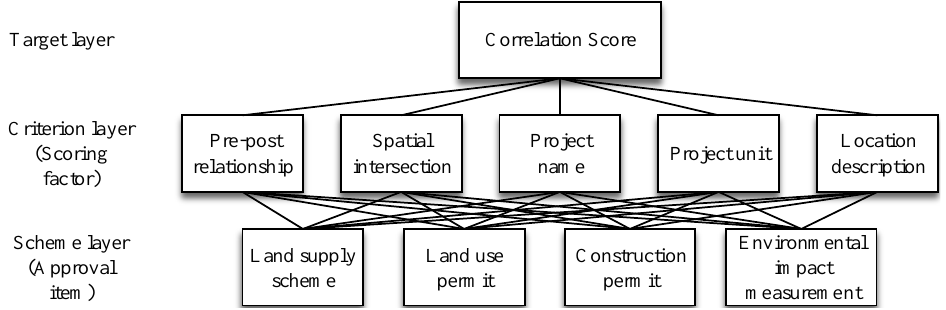
Figure 3. Analytic hierarchy model for the correlation of multi-source data from construction projects.